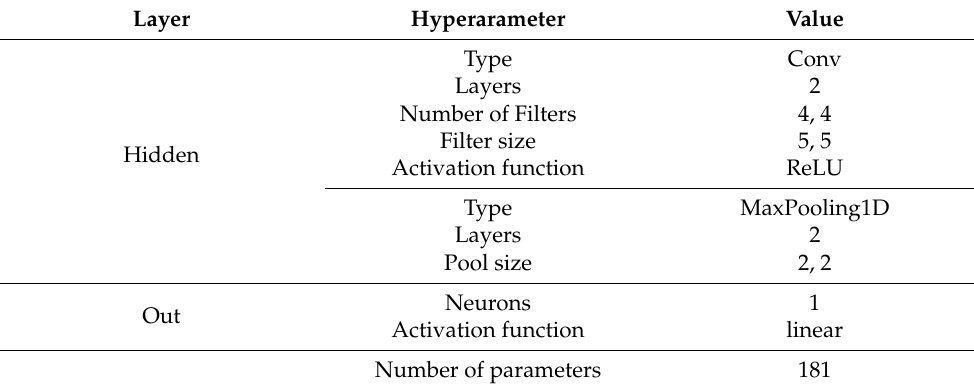
Table 3. Gülesir’s architecture hyperparameters